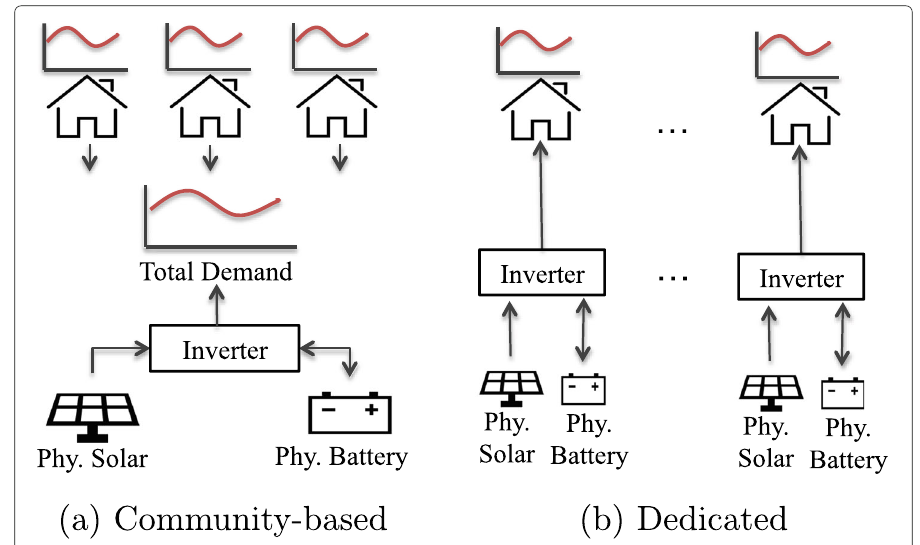
Fig. 1 Energy use in a non-virtualized community-based and a dedicated solar and battery